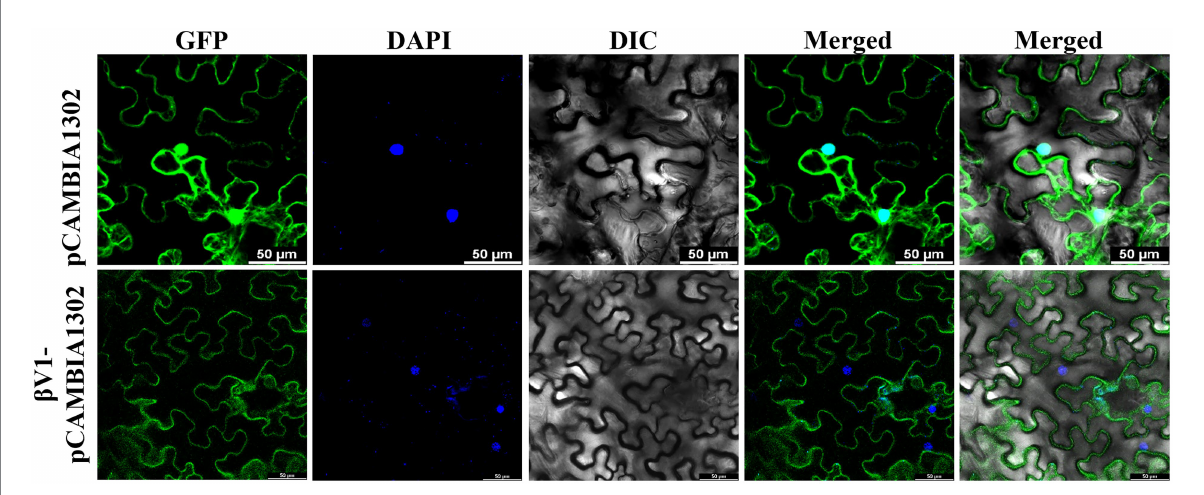
FIGURE 5 Localization of β V1 protein. The N. benthamiana leaves were agroinfiltrated either with pCAMBIA1302 or β V1-pCAMBIA1302. The epidermal cells were observed under confocal microscopy at 48 h post infiltration. Columns 1–3 show localization of GFP (upper panel) or β V1-GFP (lower panel), a nucleus stained with DAPI, DIC image of N. benthamiana epidermal cells. Columns 4 and 5 shows merged images without and with DIC images. The scale bar represents 50 μ